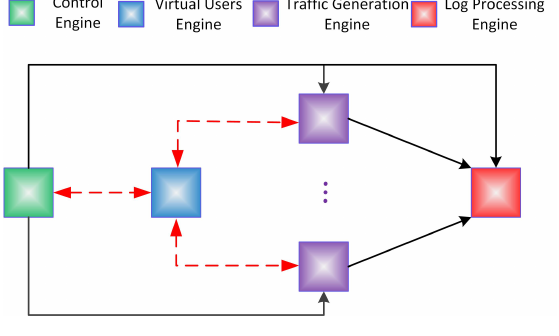
Figure 9. Based on Unix